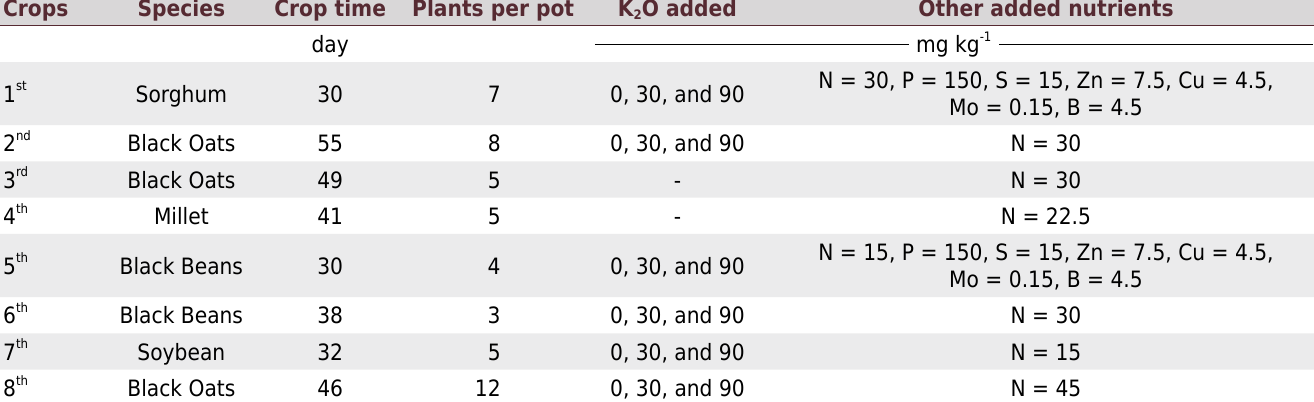
Table 2. Successive cultivation parameters used in the greenhouse study, including the crop species, growth period of each crop, number of plants per pot, and fertilizer type and quantity, in a Ferralsol from Paraná, Brazil